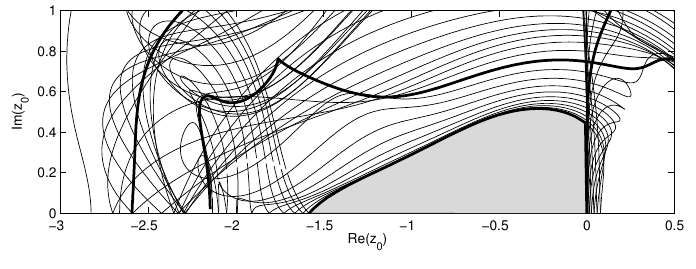
Figure 8. Stability regions S π/ 2 ,y , y = − 2 . 0 , 1 . 8 ,..., 2 . 0 (thin lines), S π/ 2 (shaded region), and S E (thick line) for β 32 = − 0 . 187138232278862, β 42 = − 0 . 949874624336551, β 43 = 0 . 143116001991357, β 52 = 1 . 048854330707973, β 53 = 1 . 729639735631708, and β 54 = 0 .